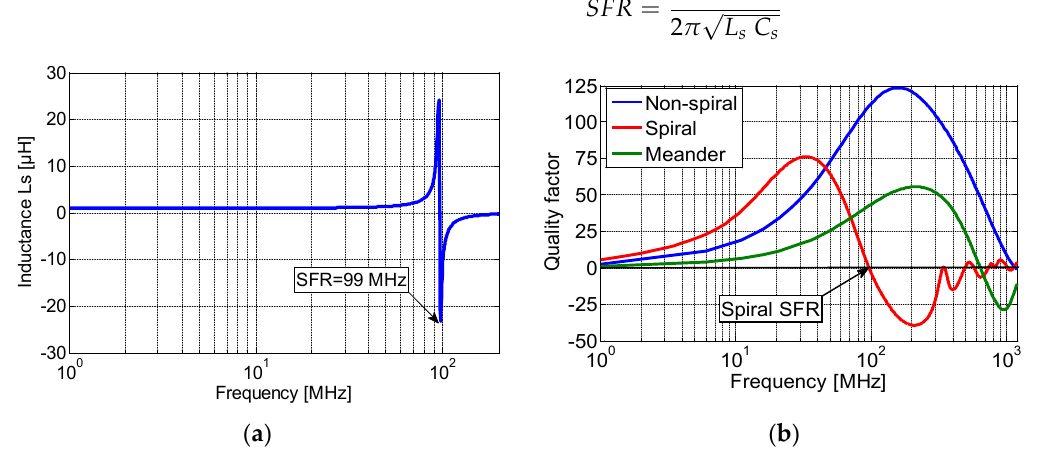
Figure 3. ( a ) The simulated inductance variation of the spiral sensor and ( b ) the simulated quality factor of the three designed inductive sensor topologies.